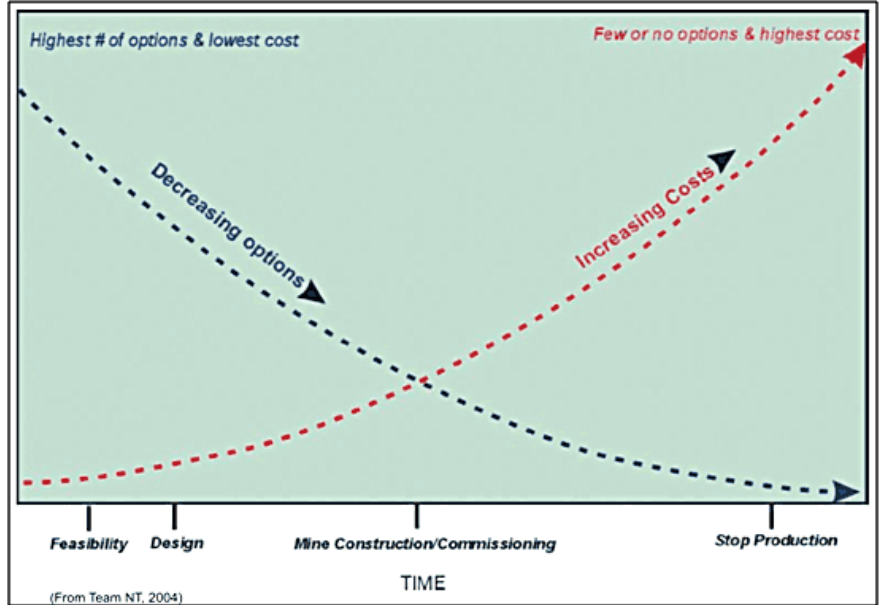
Figure 1. Options and Effectiveness with Time (TEAM NT, 2004)